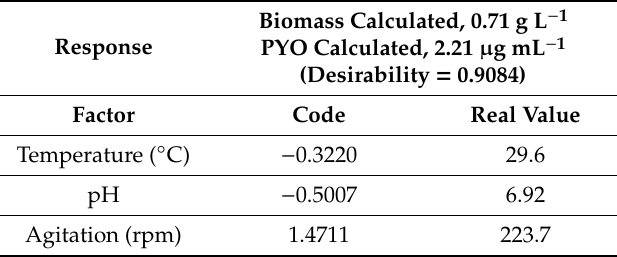
Table 3. Calculated conditions for the maximum biomass and PYO production in the defined culture